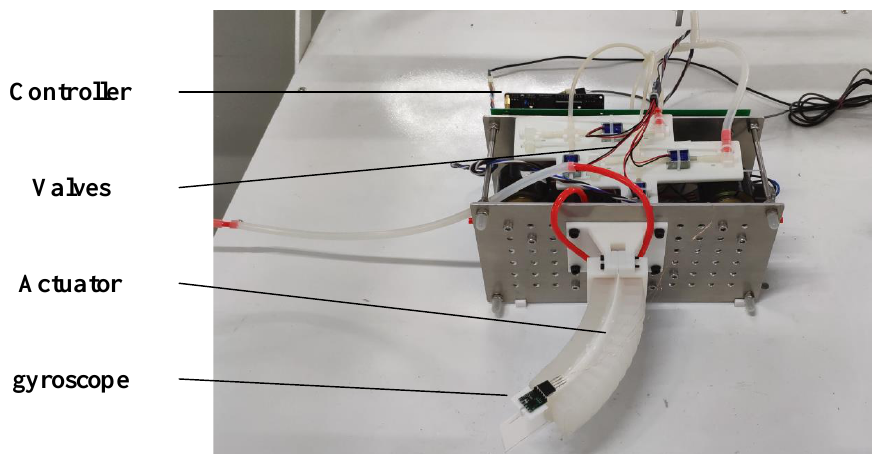
Figure 4. The experimental setup of the pneumatic